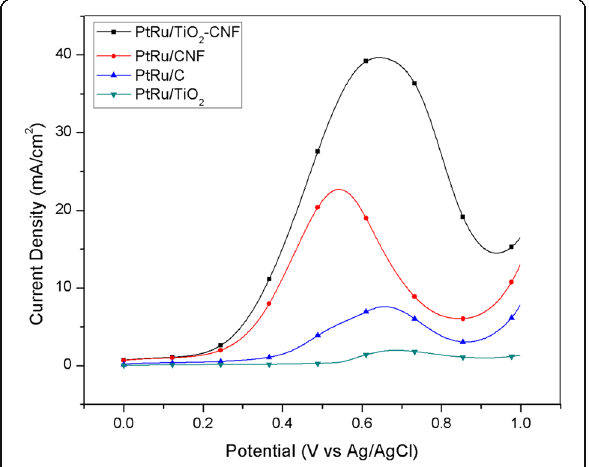
Fig. 5 LSV in 2 M methanol and 0.5 M H 2 SO 4 at the scan rate of 20 mV s − 1 for all